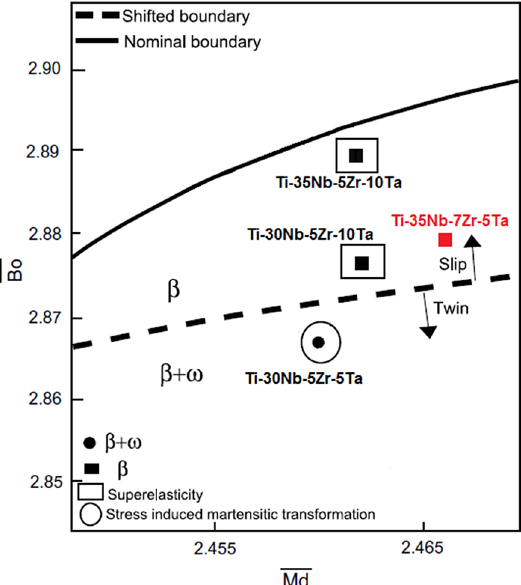
Figure 1. Magnified part of interest of the d-electron alloying map for titanium alloys. The red square indicates the strategic location at which the Ti-35Nb-7Zr-5Ta (wt%) Ti alloy is located. (Adapted from Abdel-Hady et al. 2006 9